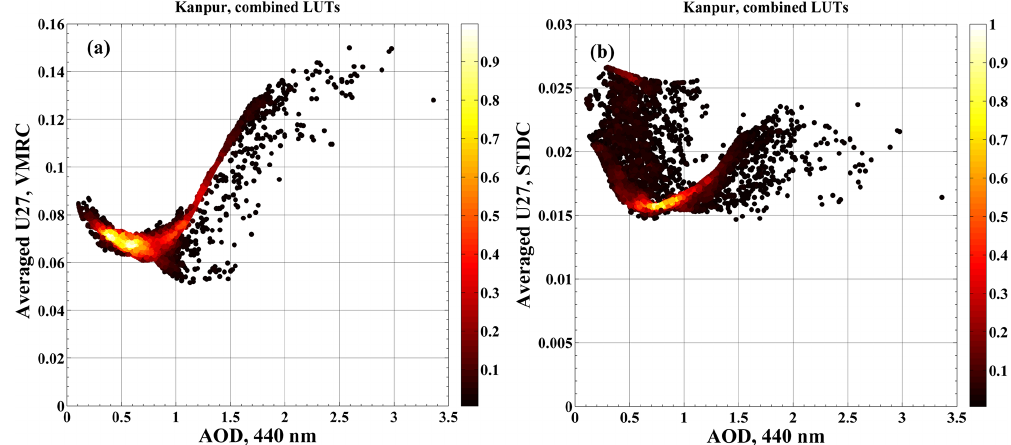
Figure 30. Uncertainties for (a) volume median radius of coarse mode and (b) width of size distribution for coarse mode estimated at the Kanpur